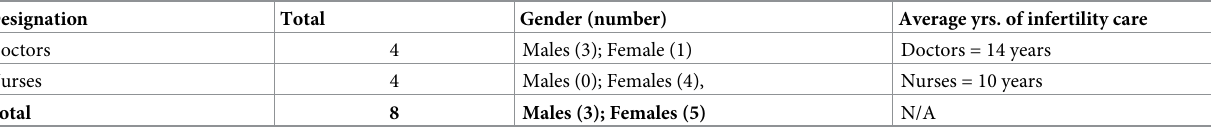
Table 2. Socio-demographic data of key